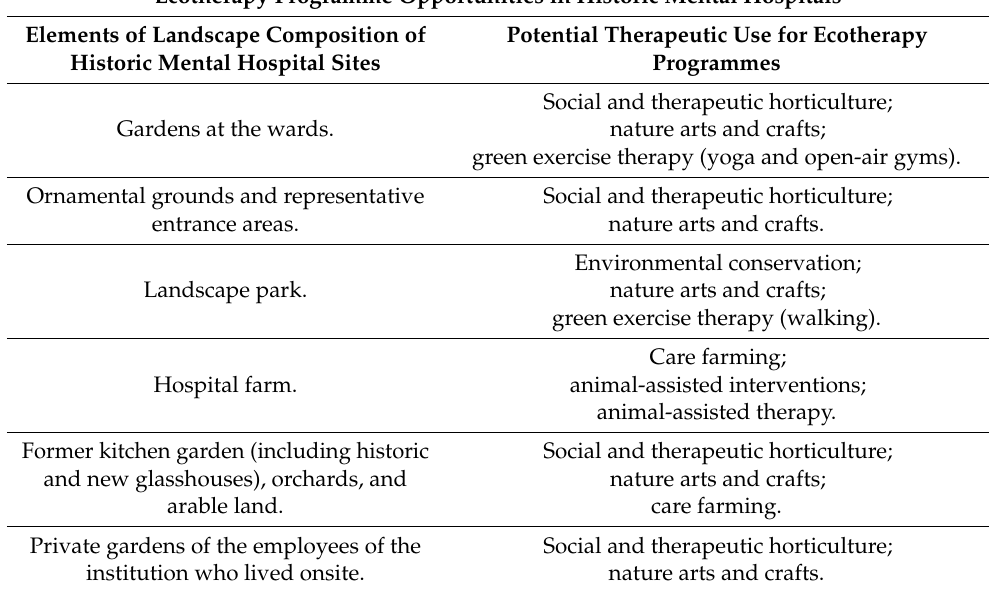
Table 3. Distinctive elements of the composition of historic mental hospitals, their sites, and their potential therapeutic use for ecotherapy programmes; source: author’s